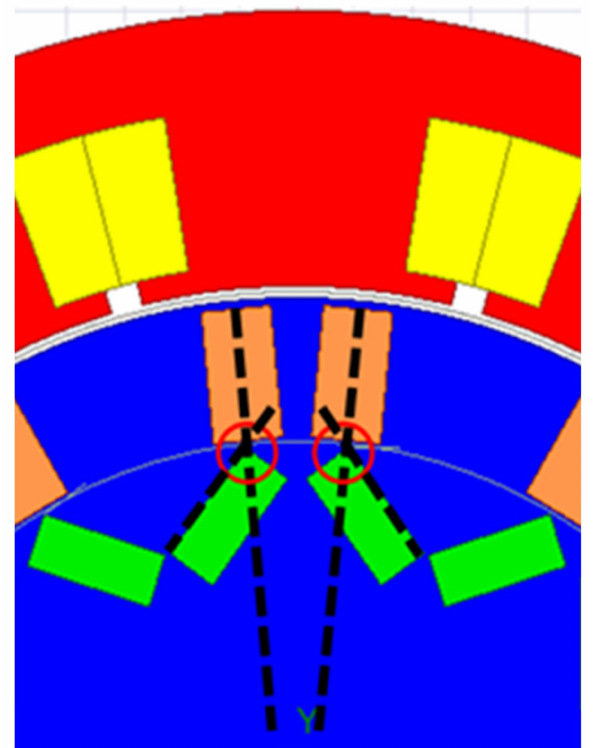
Figure 11. Schematic diagram of the low coercive force (LCF) magnet arrangement to align with the high coercive force (HCF)